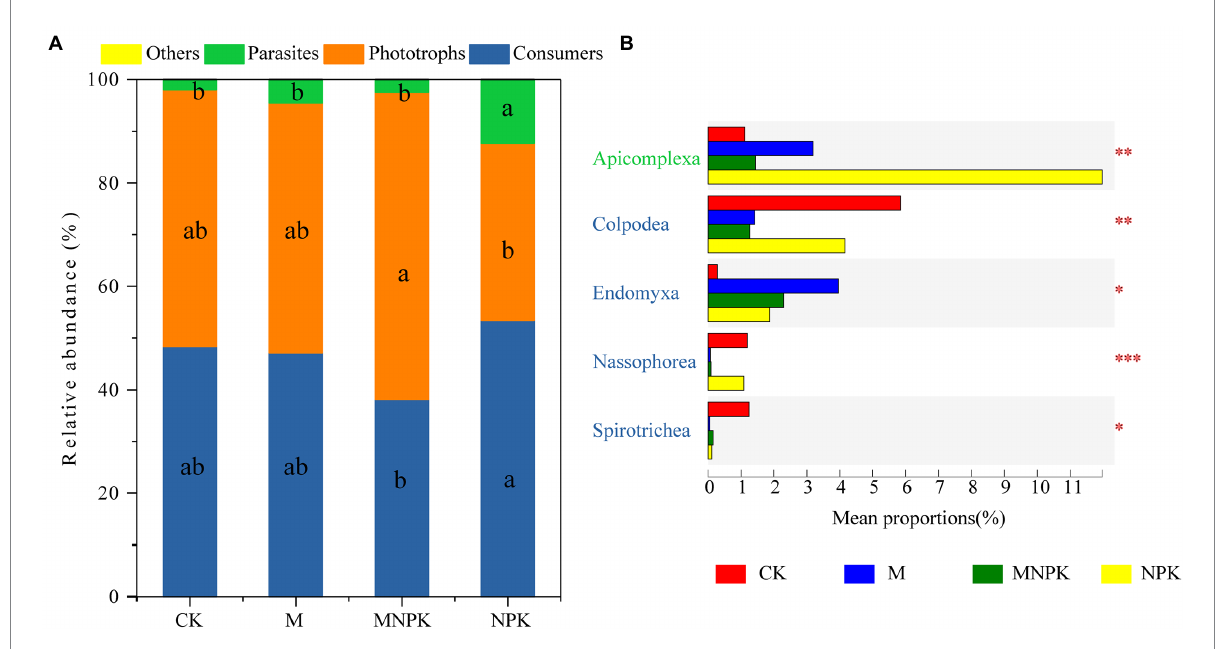
FIGURE 2 (A) Changes in the relative abundance of functional groups. Letters indicate significant differences in the relative abundance among functional groups under the effects of fertilization (one-way ANOVA, Duncan’s test; p < 0.05). (B) Boxplots of the percent relative abundance of soil protistan groups at the phylum level; colored labels represent corresponding functional categories. Difference analysis of soil protistan groups at the phylum level was identified based on Kruskal–Wallis analysis with a post hoc test (significance is indicated by * p < 0.05, ** p < 0.01, *** p <